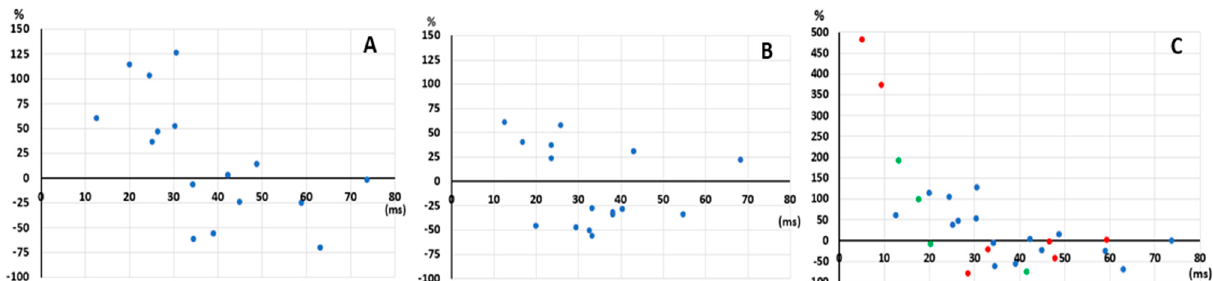
Figure 2. Comparison of pre-operative and post-operative RMSSD of each patient in the OIE group ( A ), TLE group ( B ), and IOE group in the second part of the study ( C ). Patients in each group were divided into two subgroups based on whether their pre-operative values were below or above the median RMSSD value (31 ms) of a population of 1315 healthy subjects aged 25 to 49 years (Voss et al., 2012). In the IOE group, low RMSSD tended to increase post-operatively, whereas high values tended to decrease after surgery. This pattern of HRV changes was not seen in the TLE group. ( x -axis represents the pre-operative RMSSD measures; y -axis represents the percentage of difference between pre-operative (x) and post-operative RMSSD (p) out of pre-operative value (y = 100 ∗ (p − x)/x). Each dot represents a patient. In inset C, blue dots represent IOE patients in the first part of the study, the green dots represent IOE patients but poor seizure outcome after surgery, and the red dots represent patients with temporo-insulo-opercular epilepsy. IOE = Insulo-opercular epilepsy; TLE = Temporal lobe epilepsy; pNN50 = percentage of successive RR intervals that differ by more than 50 ms; RMSSD = root mean square of successive RR interval